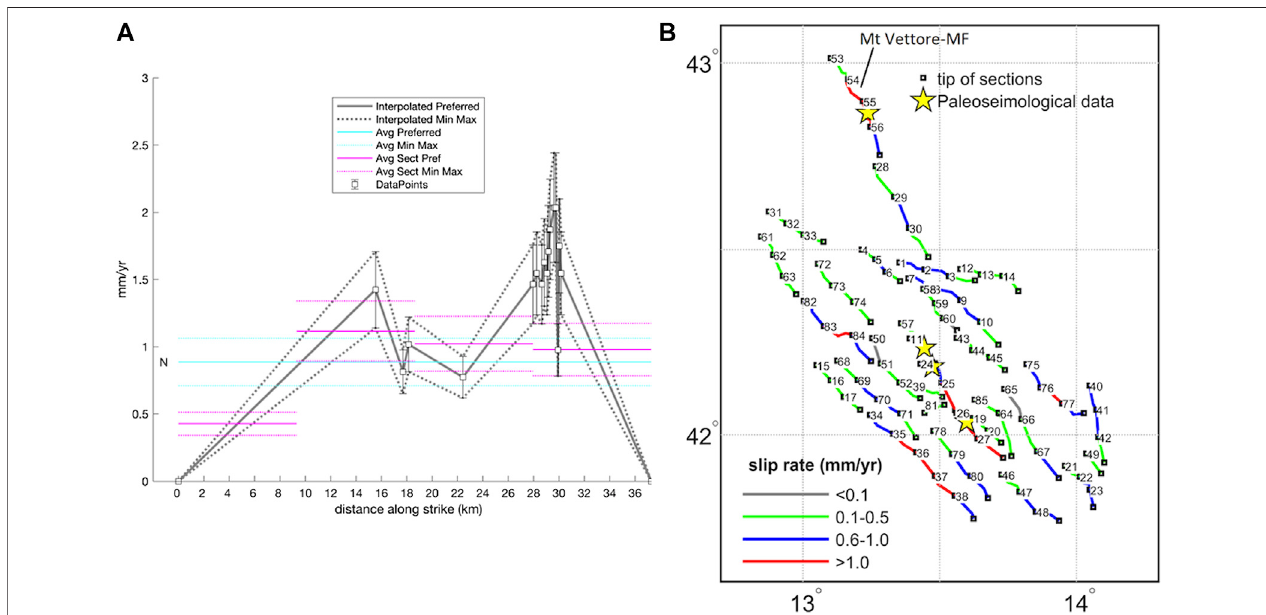
FIGURE 4 | (A) Slip rate pro fi le for the MtVettore-MF: data points with error bars are the values used to interpolate the slip rate pro fi les: solid (mean) and dotted (minimum and maximum) lines. The corresponding integral average of the slip rate pro fi les are shown with the horizontal cyan lines (for the entire MtVettore-MF) and as magenta horizontal lines for each MF-section. (B) MF-sections de fi ned inthis work represent theseismogenic sources used in the computation of earthquake ratesand for the de fi nition of rupture scenarios. Yellow stars (MF-sections #55, #11, #24 and #26) represent sites where published paleoearthquake rates will be used to compare to computed ones (see Supplementary Table S3 for names and properties of all sections).